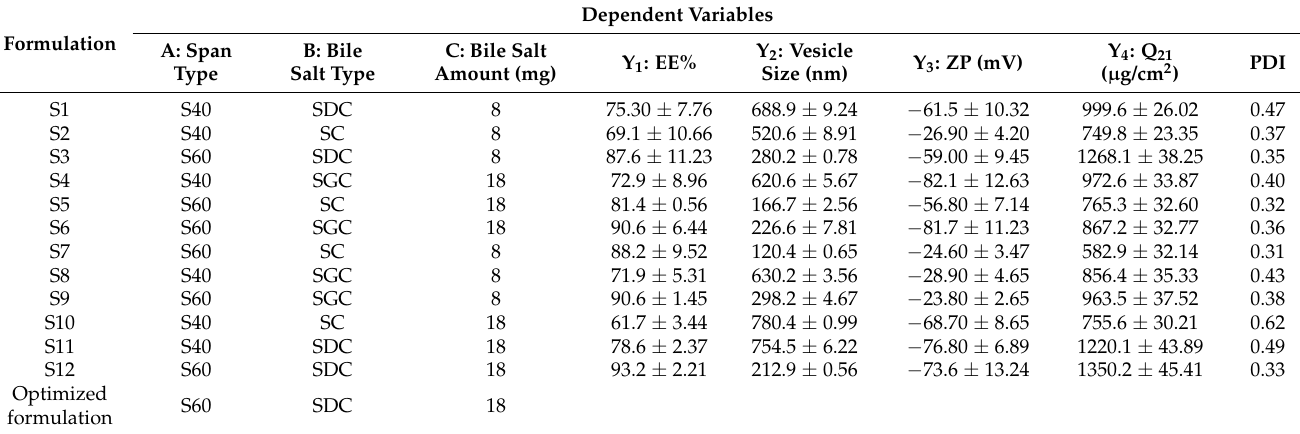
Table 2. The 3 1 2 2 multilevel categoric design and the observed responses of